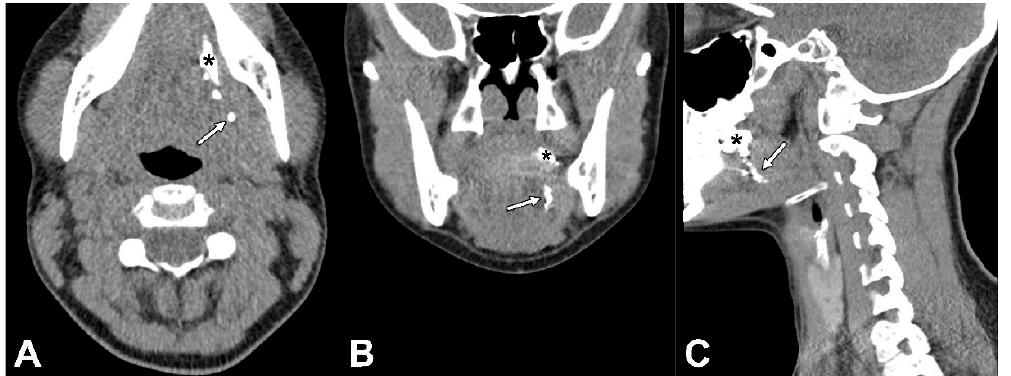
Figure 3. CT lymphographic images acquired 25 min post-injection of Lipiodol ® in the same patient (patient 6). ( A ) Axial plane, ( B ) coronal plane, and ( C ) sagittal plane; (*) injection site. Lymphatic drainage was observed (white arrows), yet no SLNs were identified on CTL in this patient.